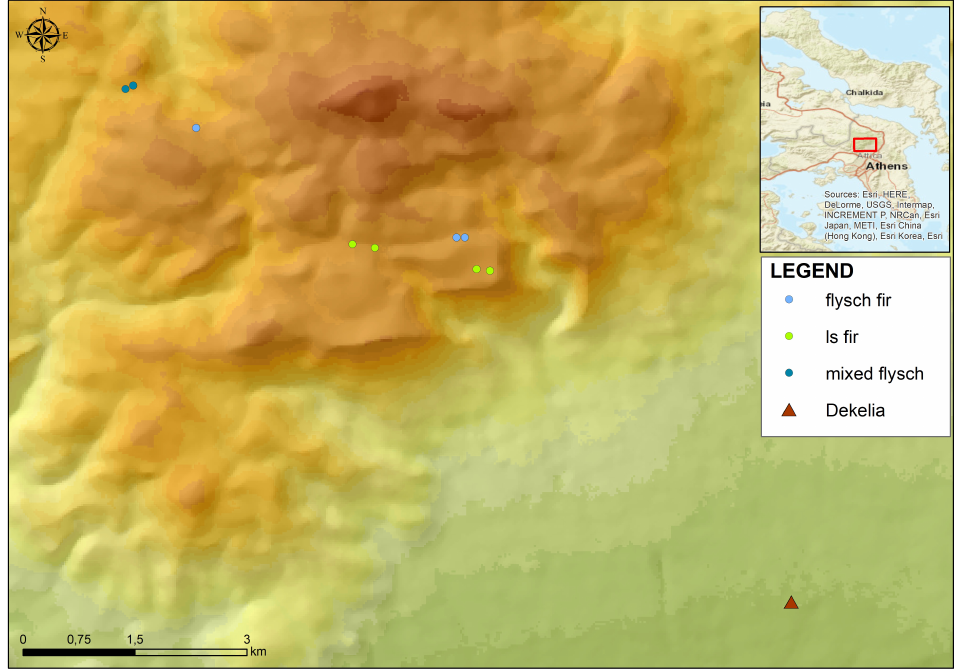
Figure 1. Study site, permanent plots and location of the Dekelia meteorological